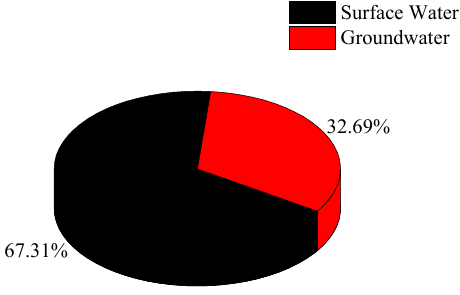
Figure 2. Proportions of energy consumption for the extraction of two categories of water resources in the city of Ordos, China, in 2017.